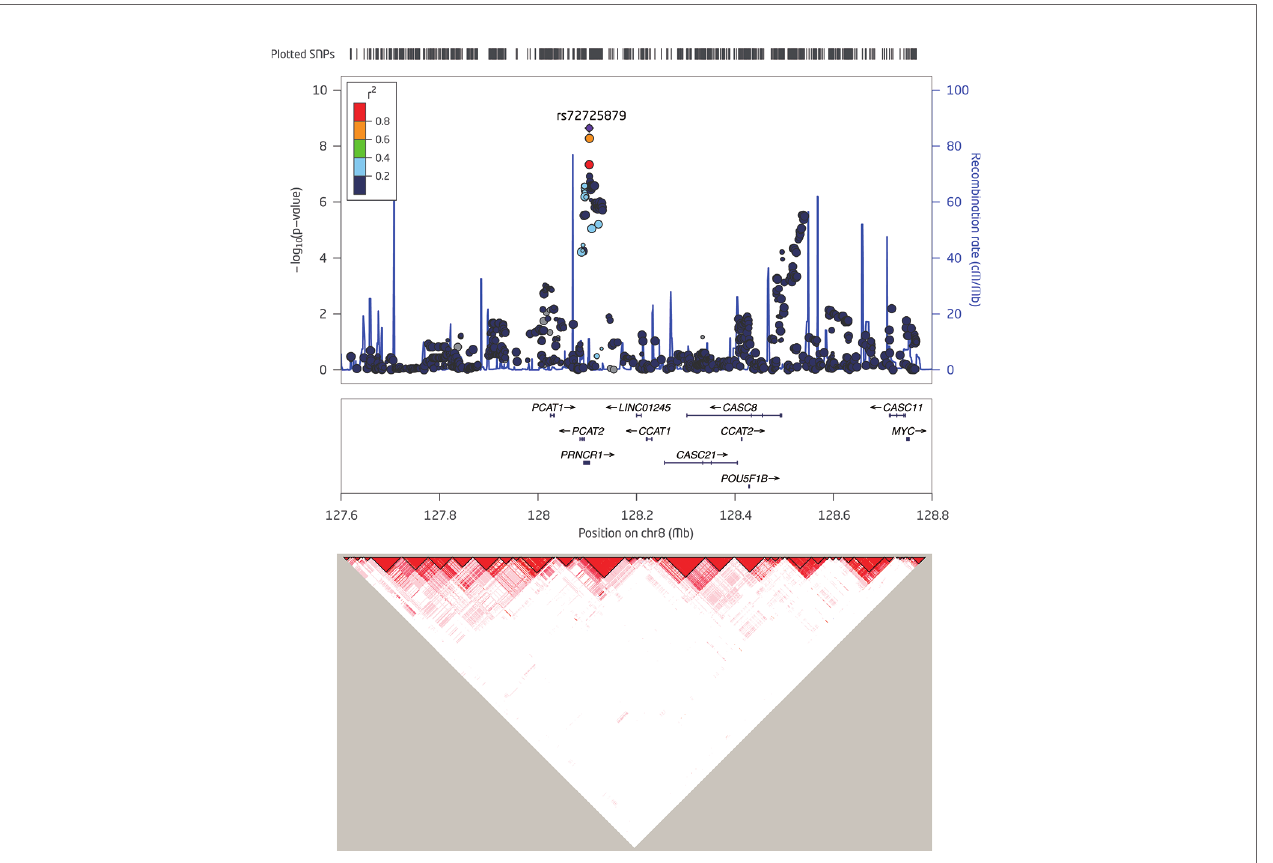
FIGURE 2 | Detailed regional plots of − log10 p -values in the 8q24.21 region shown for logp2PSA. Colors indicate the linkage disequilibrium (LD) strength between rs7272589 and the other single nucleotide polymorphisms (SNPs) assessed. SNPs with red circle are reported to be associated with risk of prostate cancer (PCa) within the 8q24.21 region for the corresponding block. The right Y -axis shows the recombination rate from the 1000 Genomes Project data as reference. LD maps were based on D ′ values using data from the two-stage